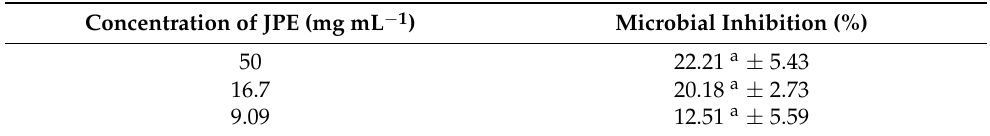
Table 1. Microbial inhibition of JPE against E.coli